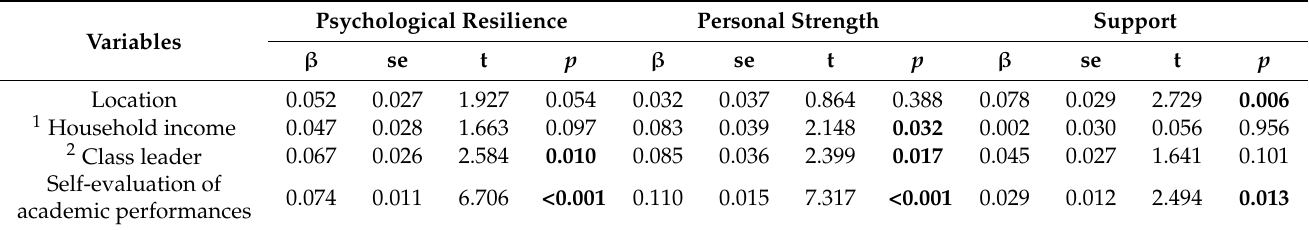
Table 2. Multivariable linear regression analysis of factors associated with psychological